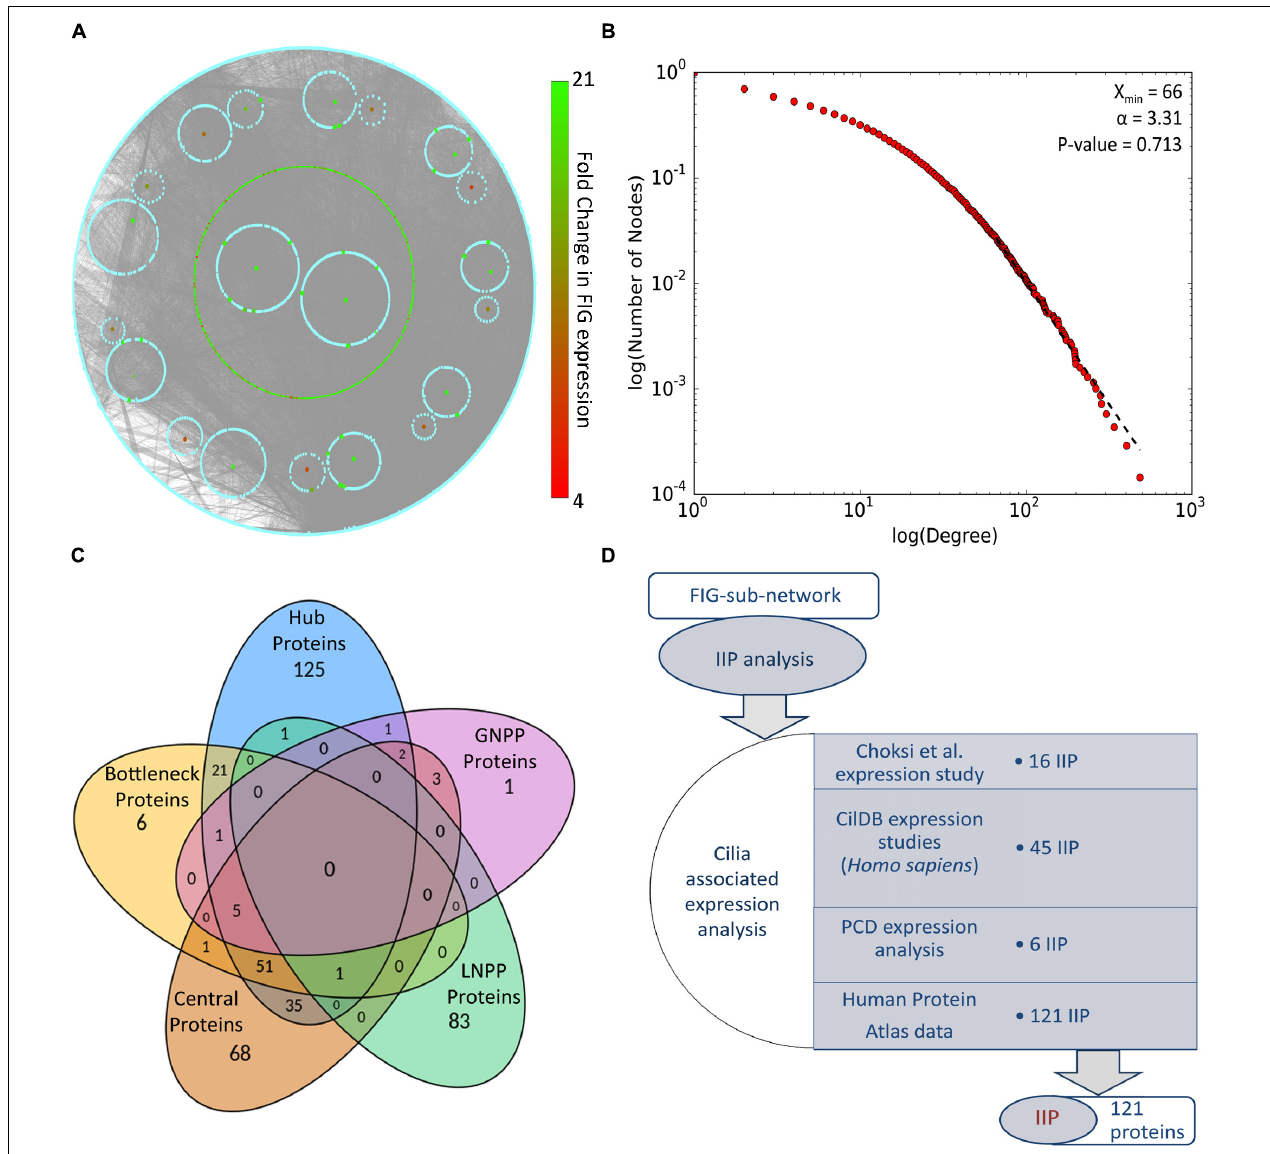
FIGURE 2 | PPIN analysis of primary interaction network of FIG-sub-network proteins. (A) The scale free network comprising of largest connected component of primary interaction network of FIGp considered for the IIP analysis is shown here. (B) The degree distribution plot and the p-value for goodness of fit of the power law to the degree distribution as determined by the Kolmogorov-Smirnov test is represented here. (C) The number of proteins identified in each category (hub, bottleneck, central, local network perturbing and global network perturbing protein) considered during IIP analysis are indicated in the Venn diagram. (D) The number of proteins that could be associated with cilia based on ‘cilia associated expression analysis’ that were considered as IIP is shown here. Abbreviations: FIG, FoxJ1 induced genes; FIGp, FIG encoded protein; IIP, Important interacting proteins; PPIN, protein-protein interaction